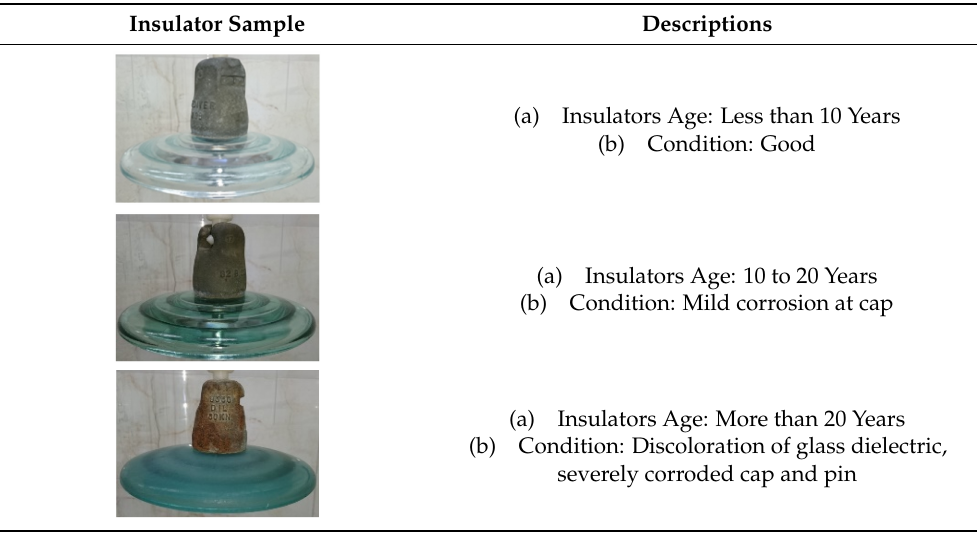
Table 3. Description of insulator samples.